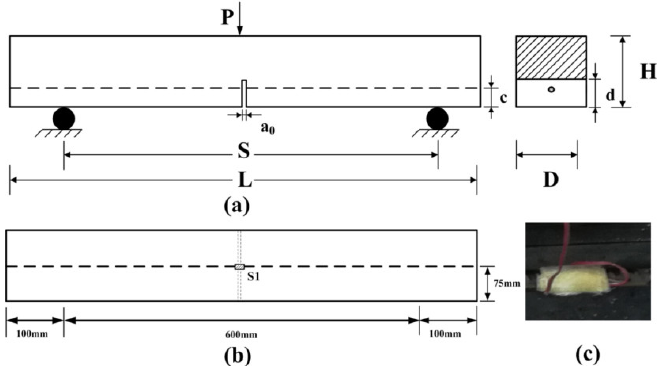
Figure 1. The setup of specimen: the schematic diagram of the specimens ( a ); the location ( b ) and photo ( c ) of strain gauge on the steel bar.